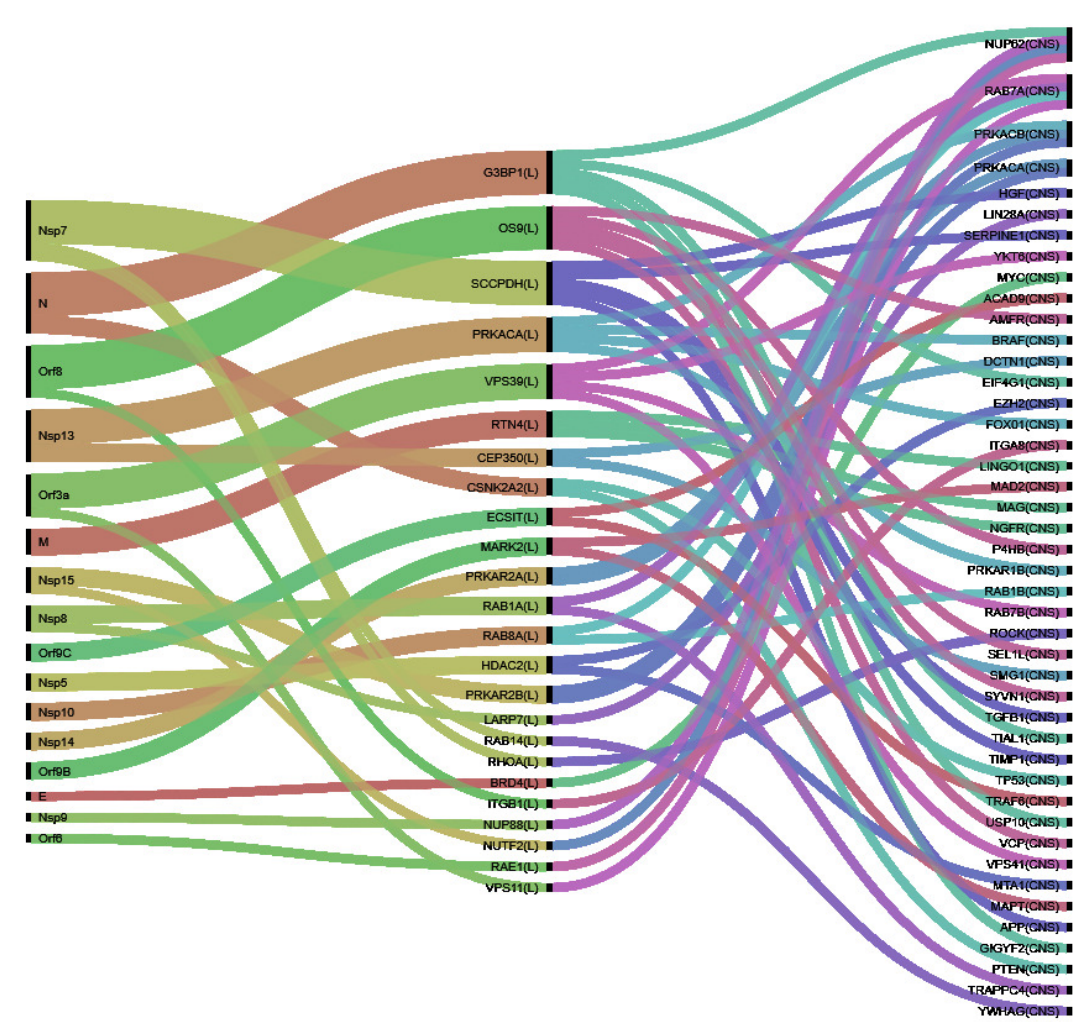
Figure 3. Cascading effects from SARS-CoV-2 proteins ( left ) to perturbators ( middle ) and from them to PD-VPs ( right